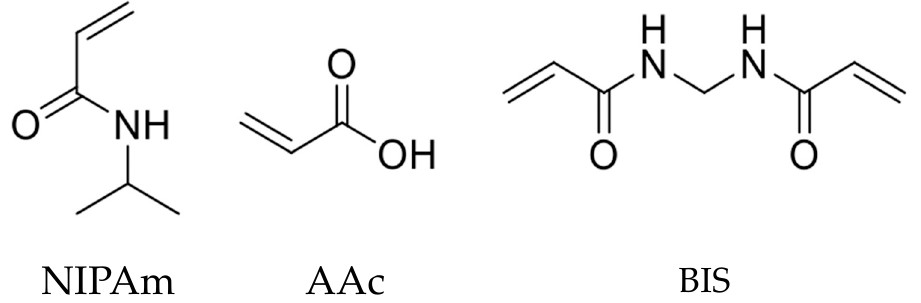
NIPAm AAc BIS Figure 1. Common monomers used in the synthesis of thermo / pH-responsive microgels. NIPAm: Figure 1. Common monomers used in the synthesis of thermo/pH-responsive microgels. NIPAm: N- N-isopropylacrylamide, AAc: acrylic acid, BIS: N,N’ -methylenebisacrylamide. isopropylacrylamide, AAc: acrylic acid, BIS: N,N’ -methylenebisacrylamide.